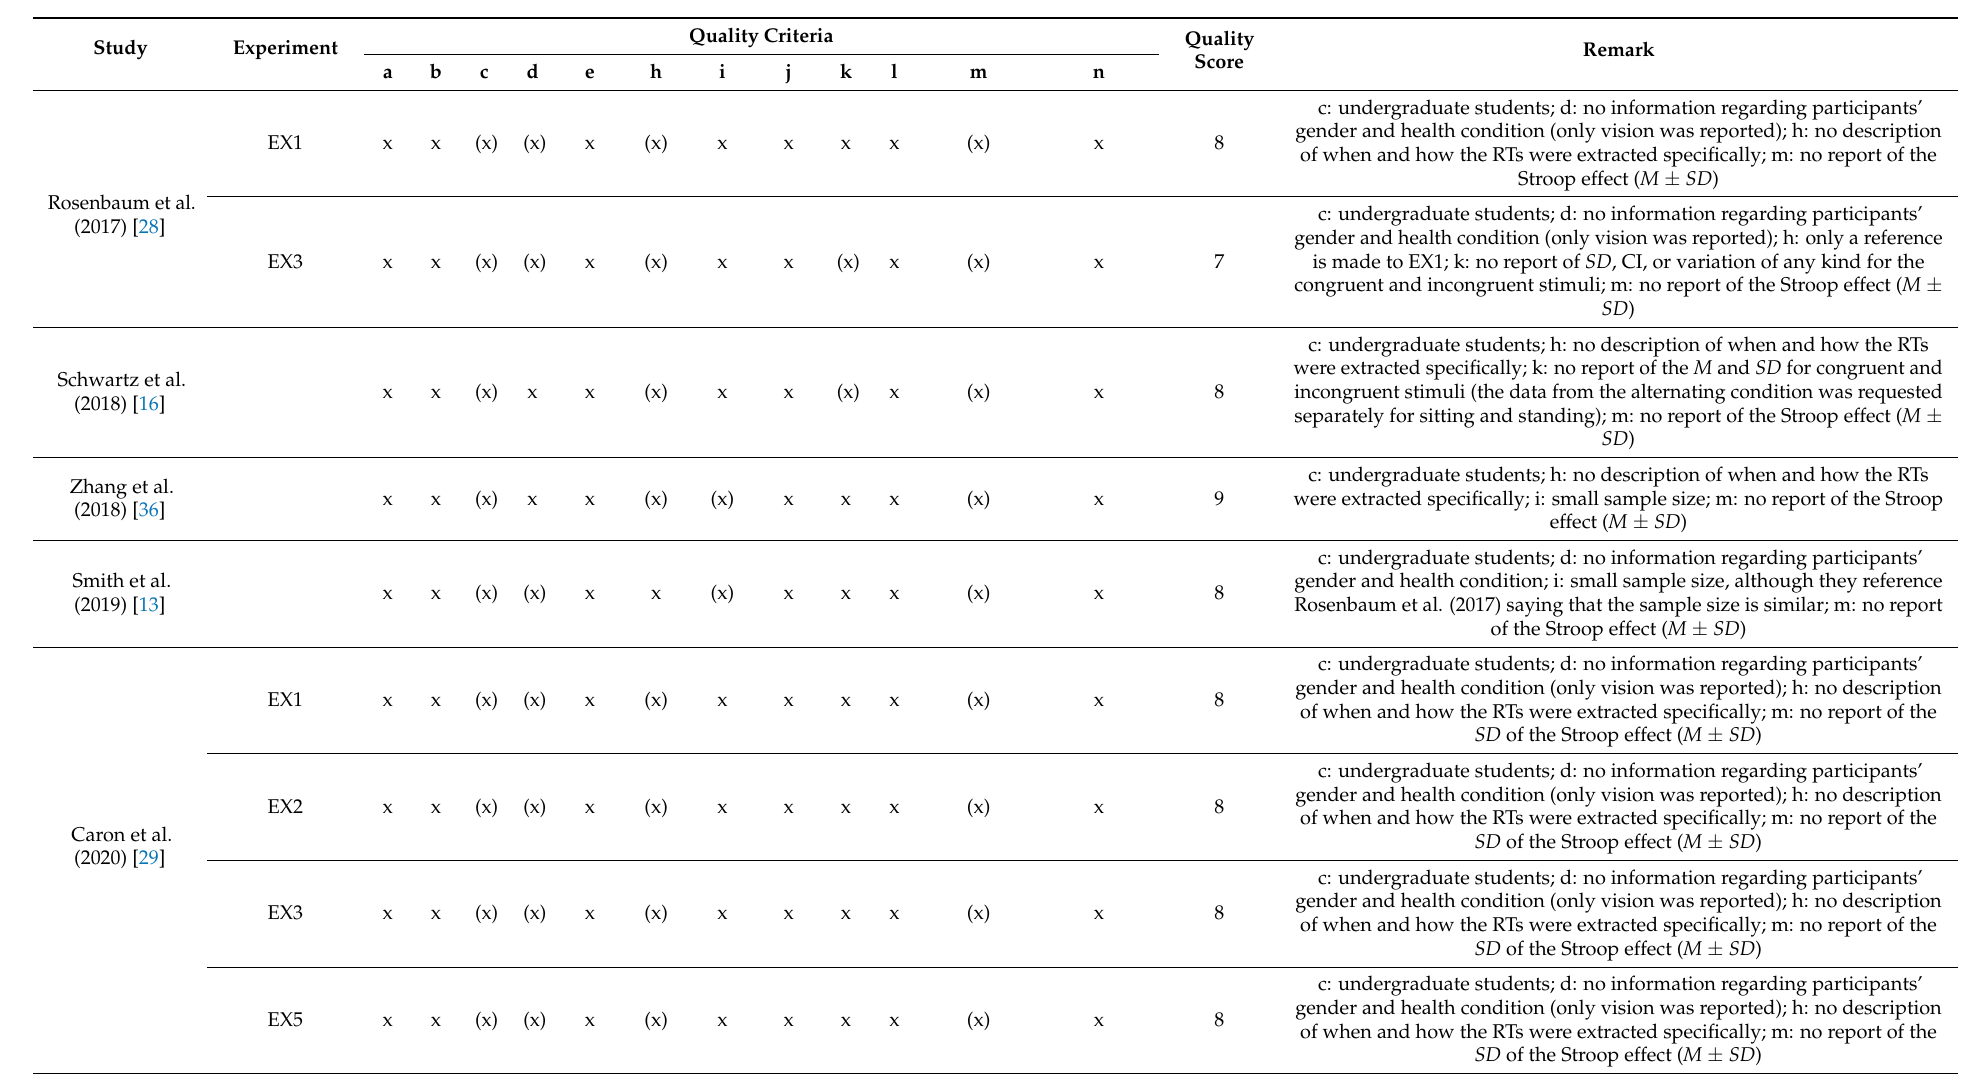
Table 1. Quality scores of the included studies and